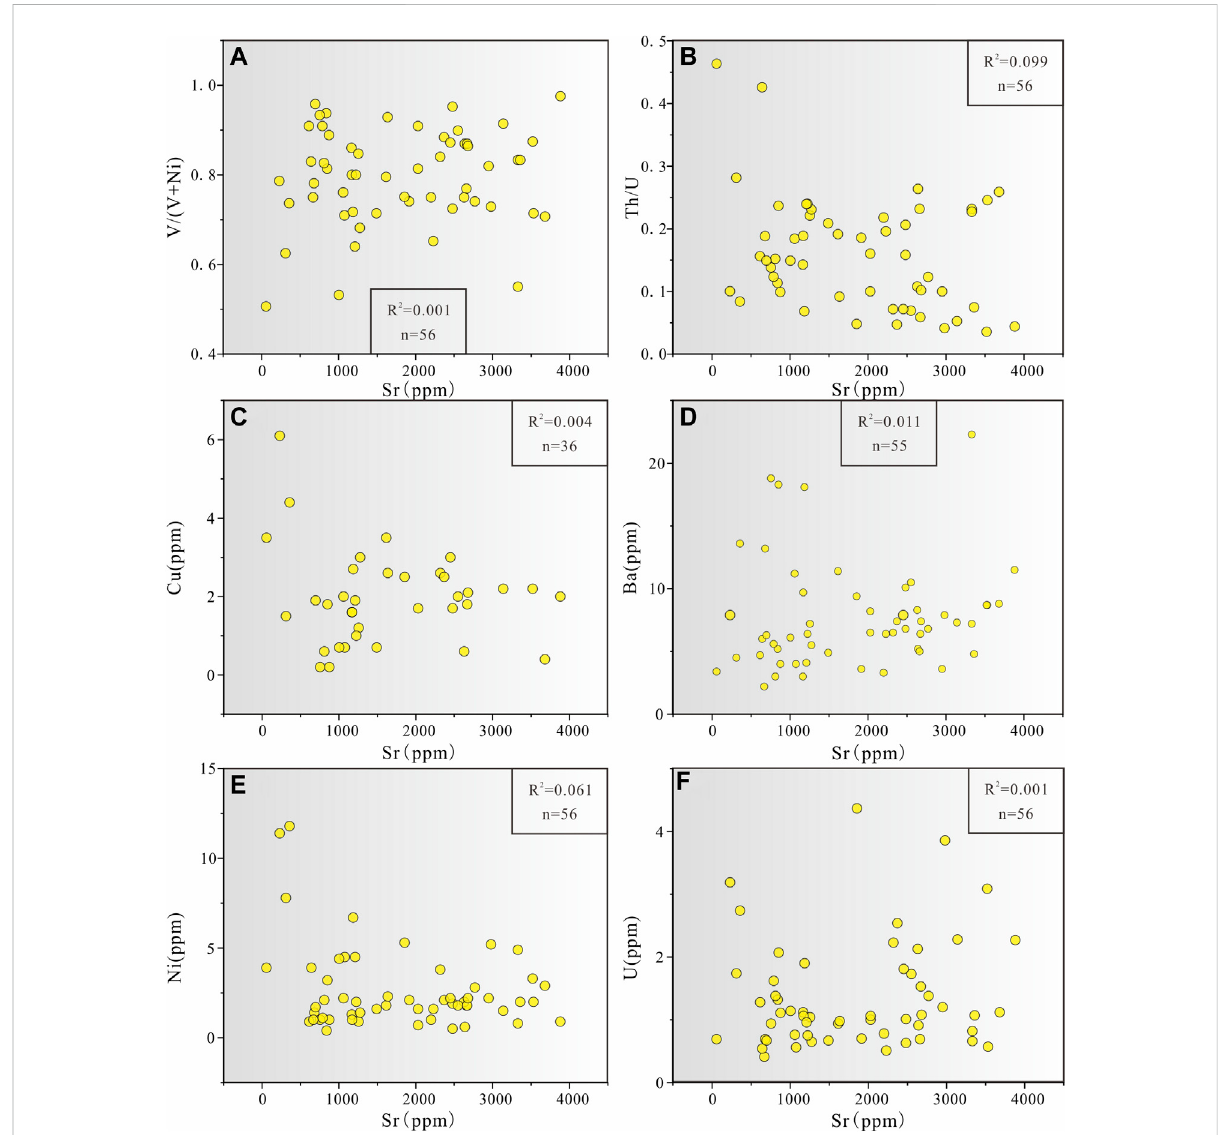
FIGURE 7 Scatter diagrams showing correlations of Sr with (A) V/(V+Ni), (B) Th/U, (C) Cu, (D) Ba, (E) Ni, and (F) U in the investigated Dukou section.